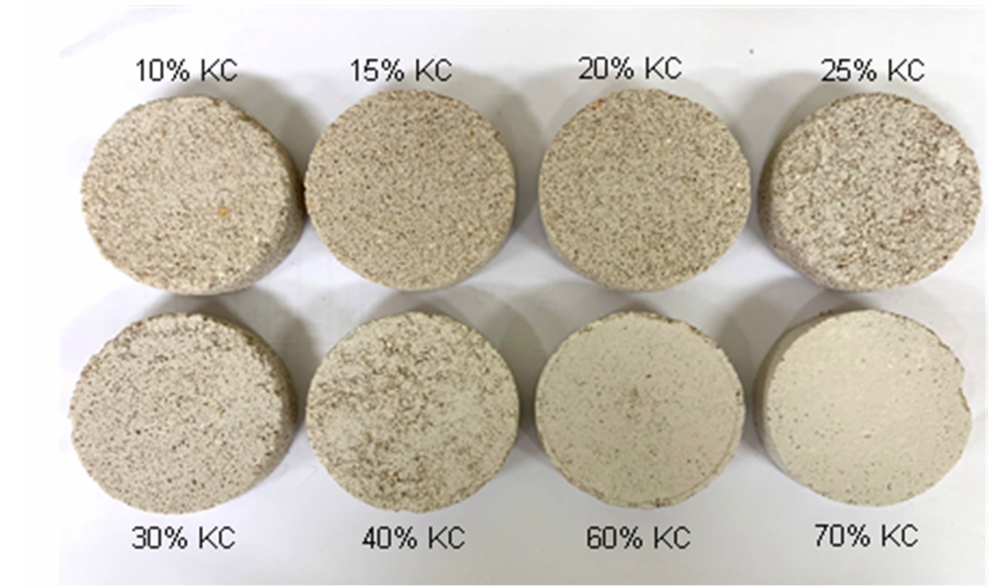
Figure 3. Top view of all specimens after the oedometer